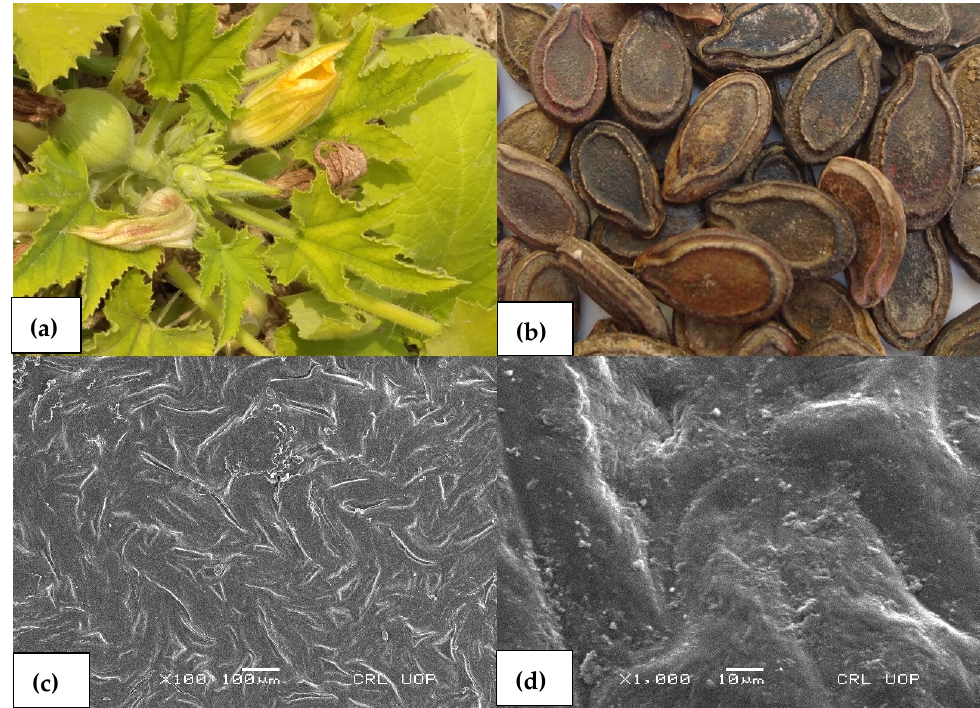
Figure 3. Praecitrullus fistulosus ( a ) plant, ( b ) seeds, and ( c , d ) SEM micrograph of seed sculpturing.